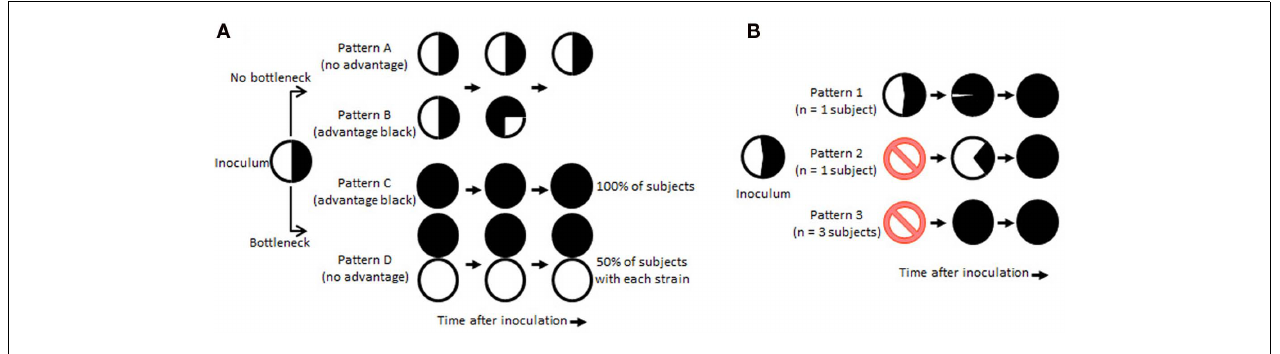
populations of gonococci recovered from infected subjects. In (B) , actual outcomes are shown for infections initiated by a 45:55 mixture of isogenic Tf + Lf − (white) andTf + Lf + (black) strains of N. gonorrhoeae FA1090 (Anderson et al., 2003). In patterns 1–3, each pie chart represents the mixture of gonococcal strains recovered from infected subjects over the 1- to 5-day period after inoculation.The (cid:3) symbol indicates no gonococci were recovered at early times (1–3days in different volunteers) after inoculation of four